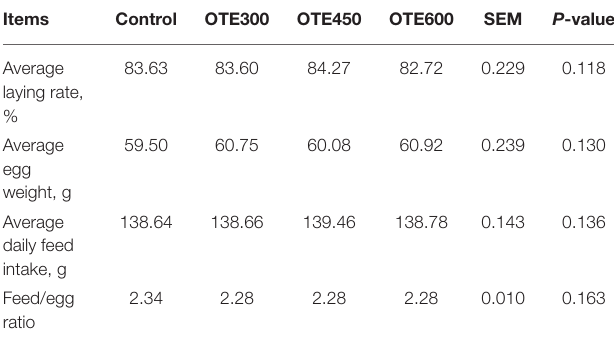
TABLE 3 | Primer sequences used for quantitative real-time PCR (qRT-PCR). Target Genes